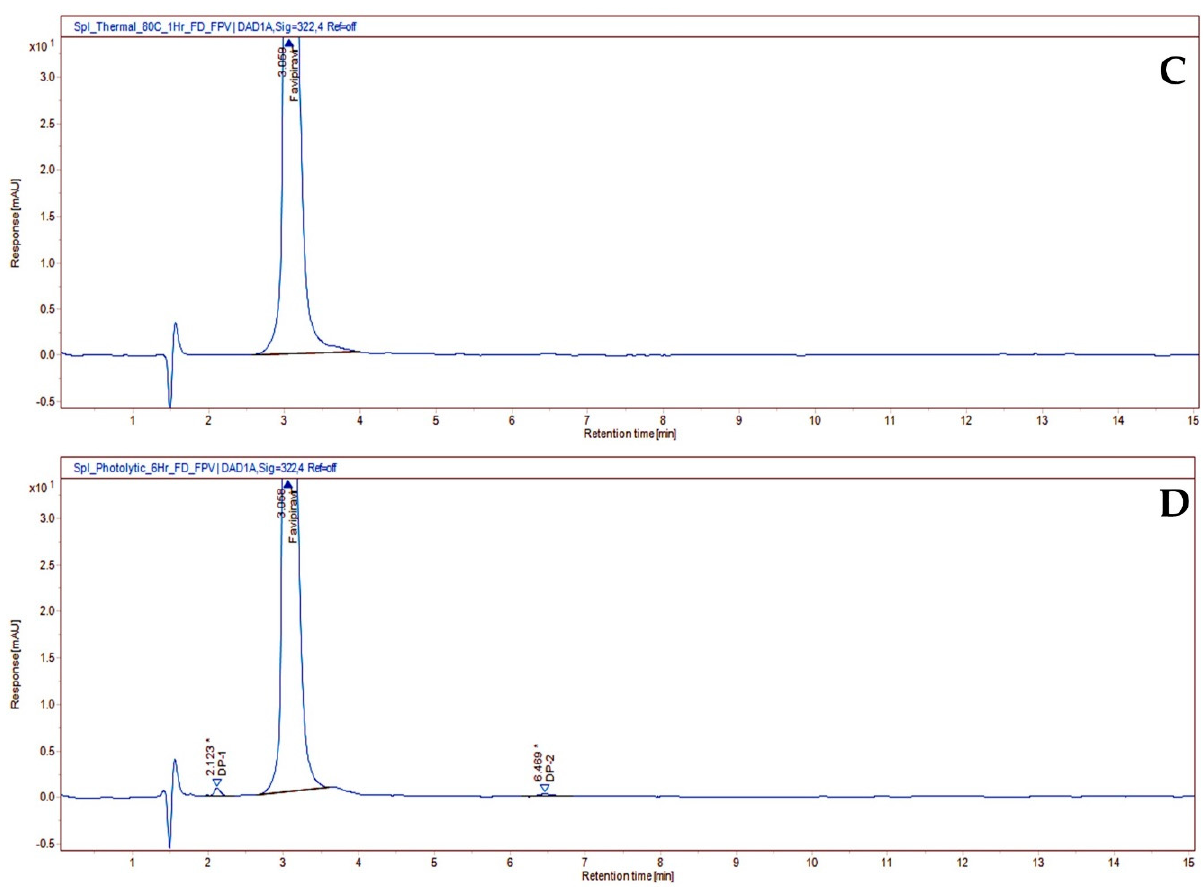
Figure 4. Chromatogram of acid degradation under 5 N HCl ( A ); peroxide degradation under 30%H 2 O 2 ( B ); thermal degradation under 80 ◦ C ( C ); and photocatalytic degradation under 6 h UV light ( D ) of favipiravir in its oral suspension. Table 1. Summary data of forced degradation